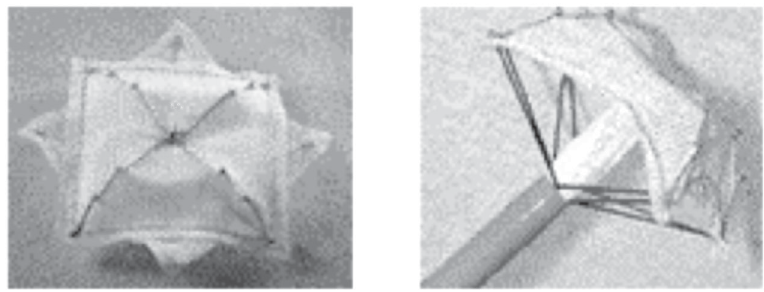
Figure 5. Atrial septal occlusion device. Taken from Ref. 26